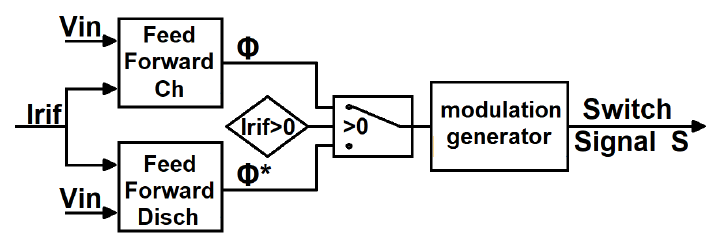
Figure 12. Converters control